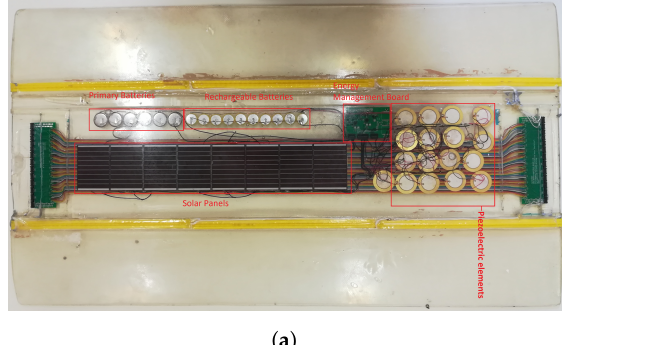
Figure 14. ( a ) The energy management board encapsulated in resin along with the harvesters and batteries for use on road infrastructure; ( b ) IoT device with sensors and communication modules, mounted on the road surface with suitable encapsulation. The energy part is the one closer to the side of the